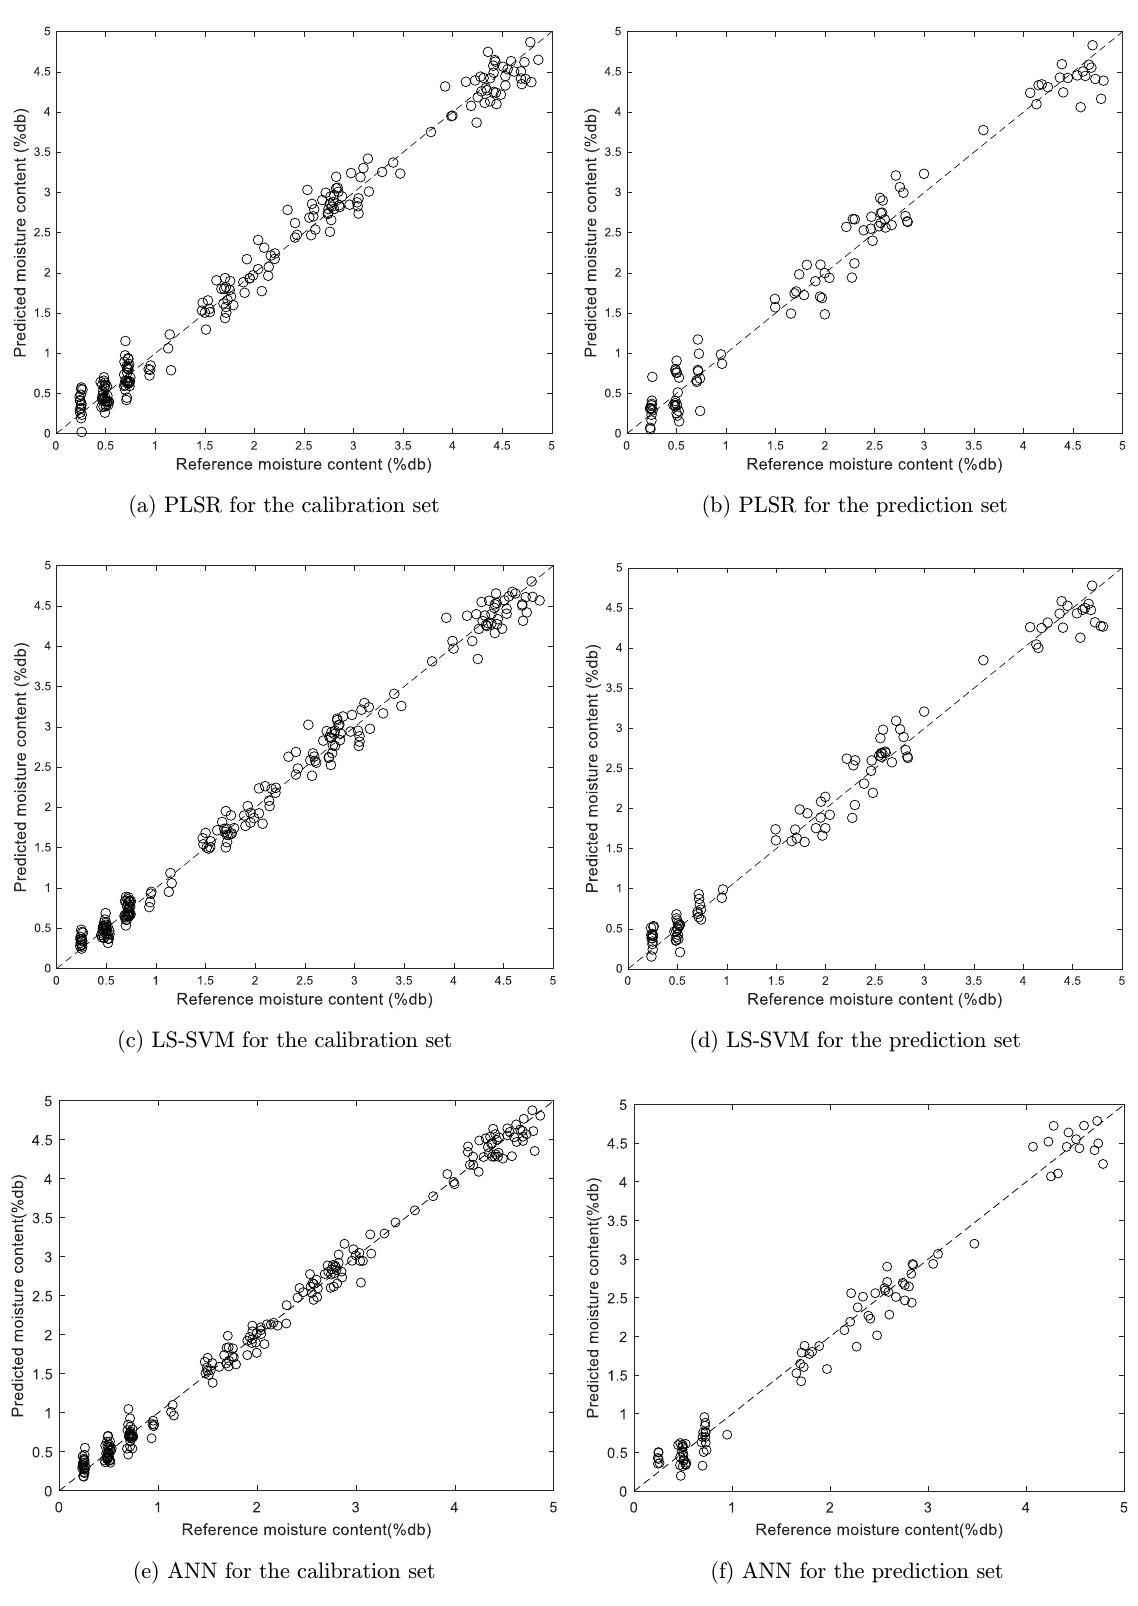
Fig. 8. Scatter plot of predicted and reference moisture content for PLSR, LS-SVM, and ANN models using calibration and prediction